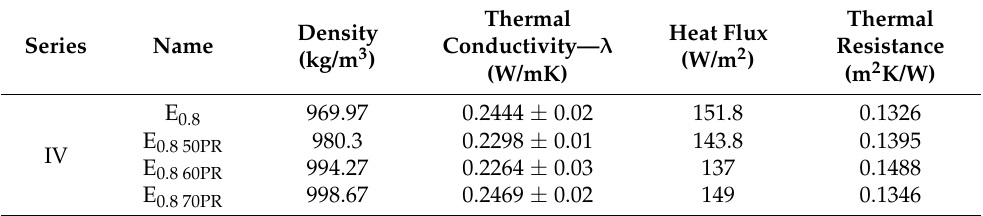
Table 4. Apparent density, thermal conductivity, heat flux, and thermal resistance (UNE-EN 12667).